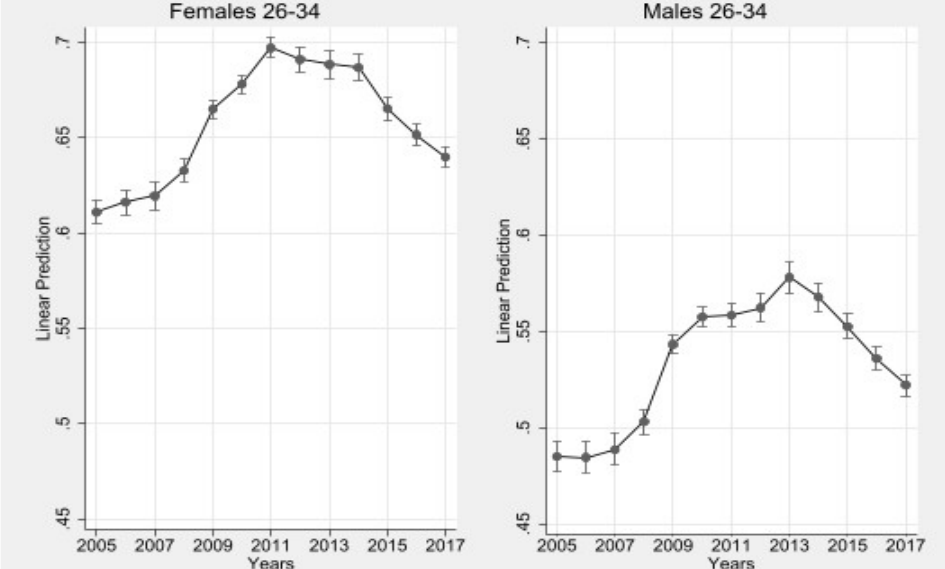
Figure 6 : Predicted probability of youth between 26 to 34 living out of the parental home by gender and year.